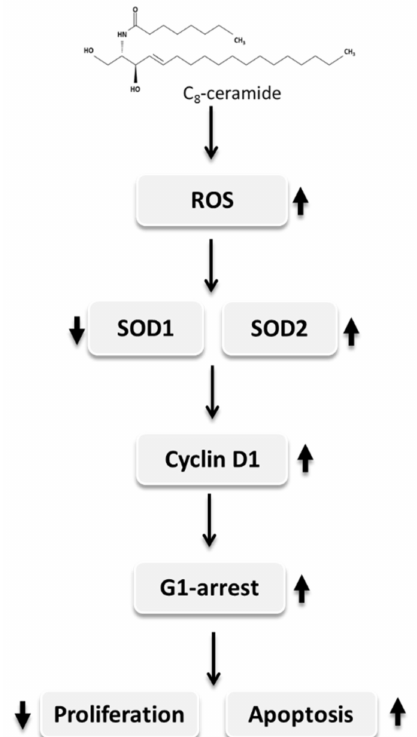
Figure 7. A proposed model of C 8 -ceramide-induced apoptosis and anti-proliferation of non-small-cell lung cancer cells by modulating the differential expressions of superoxide dismutases and cell cycle G1 arrest. After C 8 -ceramide treatment, the SOD1 to SOD2 switch stimulated by ROS induces the excess accumulation of cyclin D1, a feedback loop, which in turn causes cell cycle G1 arrest. Eventually, C 8 -ceramide induces the growth arrest and the apoptotic cell death in lung cancer H1299 cells. The upwards arrows and downwards arrows indicate the upregulation and downregulation